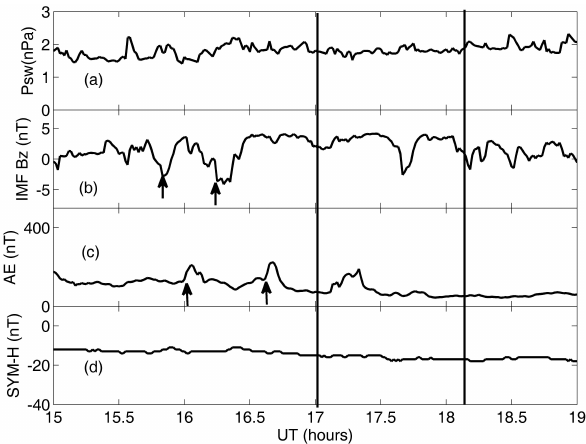
Figure 1. (a) Solar wind dynamic pressure, (b) interplanetary magnetic field (IMF) B z component, (c) AE index, (d) SYM- H index, between 15:00 and 19:00UT on 3 June 2004. The ar- rows in panel (b) denote two southward turnings. The arrows in panel (c) denote two sharp increases of the AE index. The interval of interest is denoted by two vertical solid